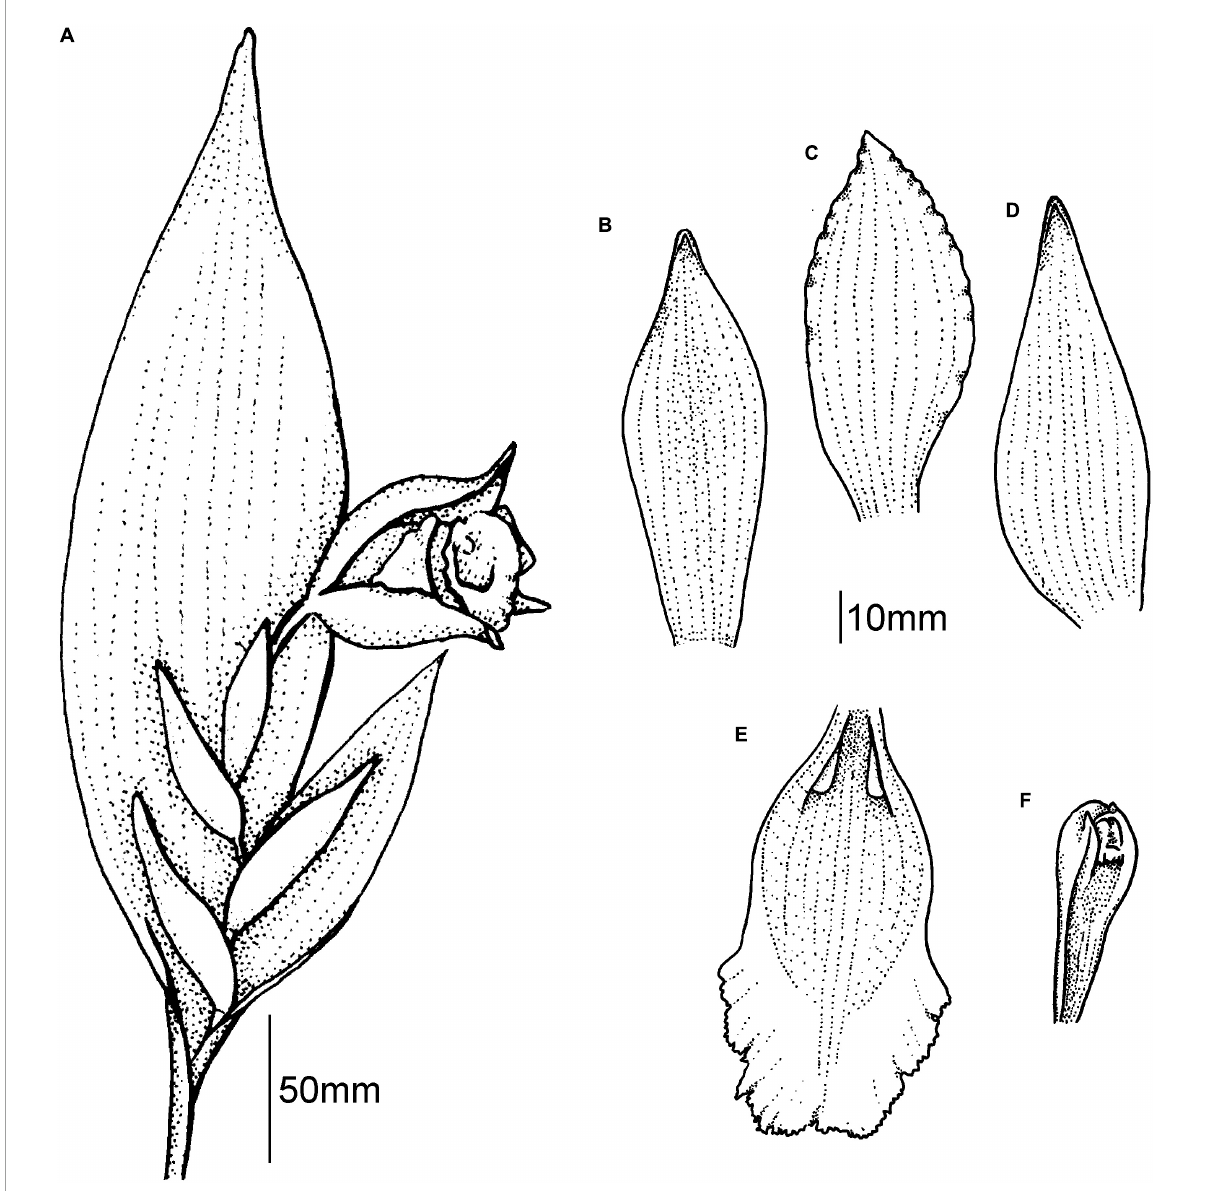
FIGURE11 Sobralia tamboana Dodson (A) apical part of stem with inflorescence, (B) dorsal sepal, (C) petal, (D) lateral sepal, (E) lip, and (F) gynostemium, front view [drawn by P. Baranow from Dodson